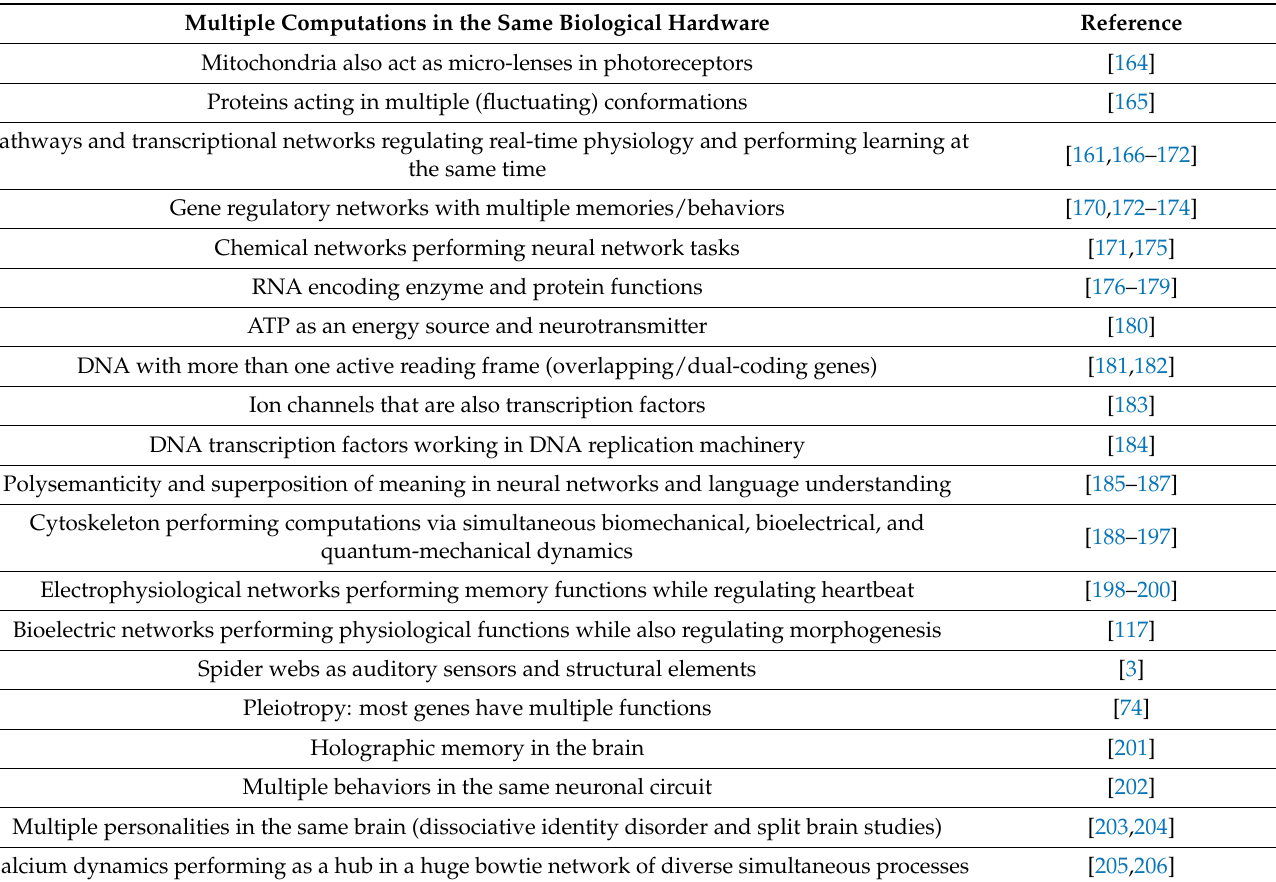
Table 2. Examples of biological polycomputing at diverse